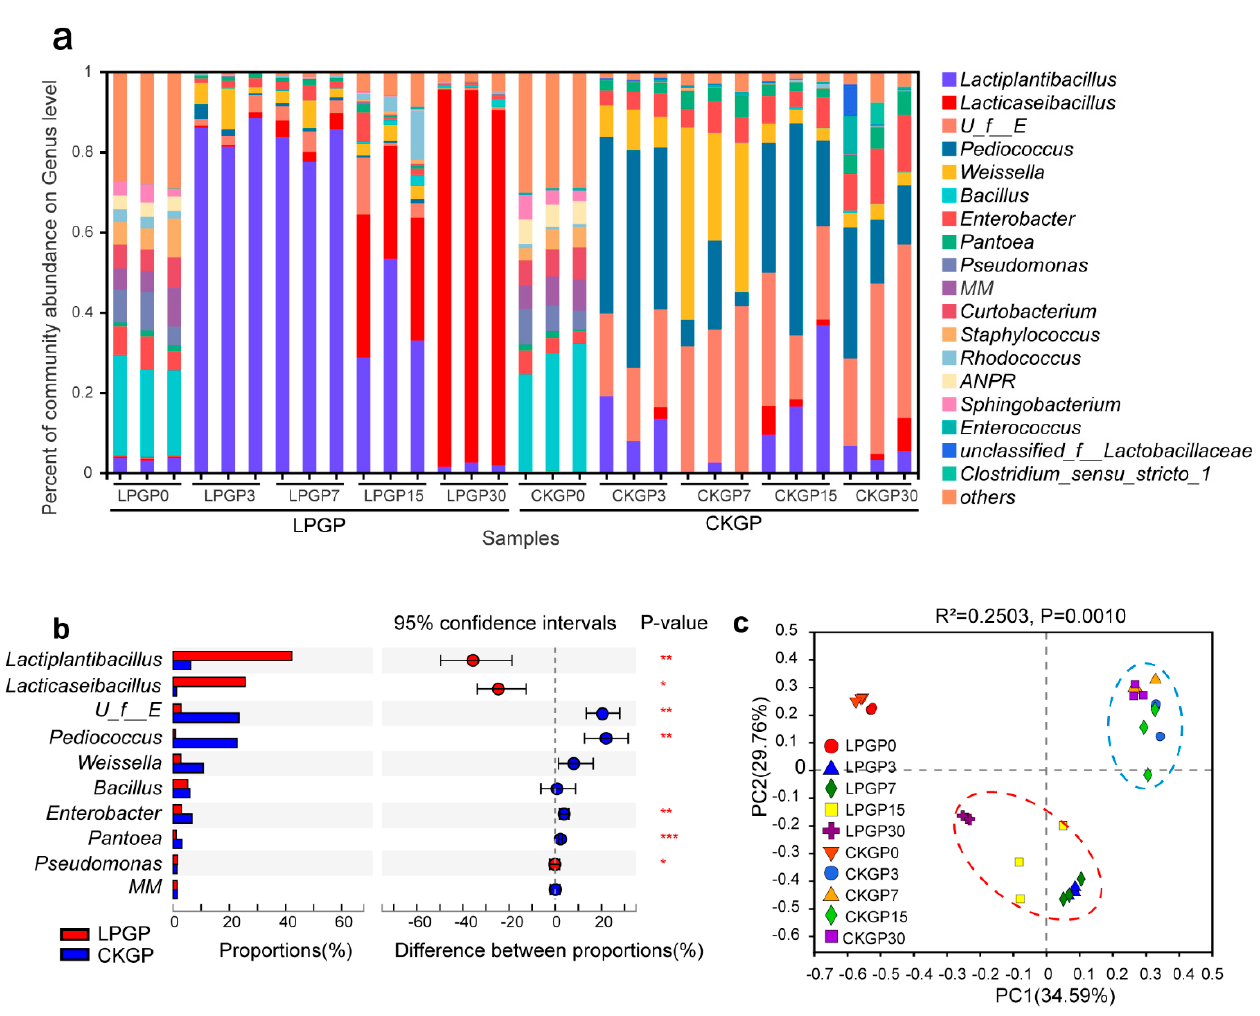
Figure 1. Effect of Lactiplantibacillus plantarum additive on the bacterial community dynamics of cabbage and rice straw silage. ( a ) The relative abundance of bacterial taxa at the genus level; taxa with <1% of reads were combined as “others”. ( b ) Wilcoxon rank-sum analysis of significant bacterial genera between silages without and with inoculation; ***, **, and * represent p < 0.001, p < 0.01, and p < 0.05, respectively. ( c ) Principal coordinate analysis was based on bacterial OTU level. CKGP: The control group; LPGP: The inoculation group. The numbers following the CKGP and LPGP indicate the sam-